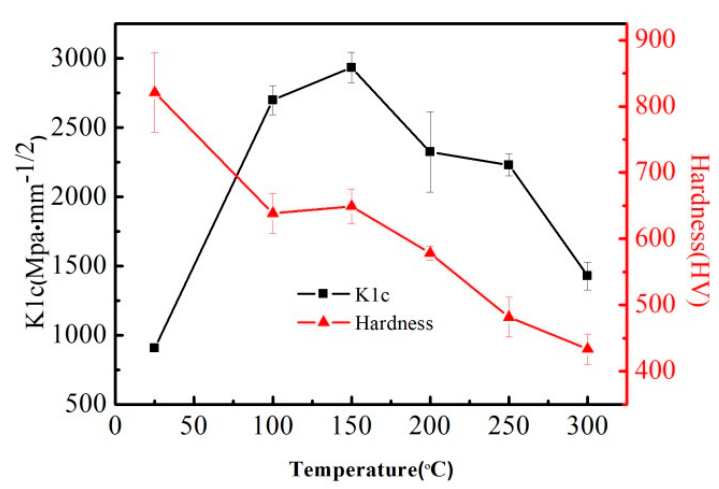
Figure 9. Effect of preheating on microhardness and plane fracture toughness of weld.